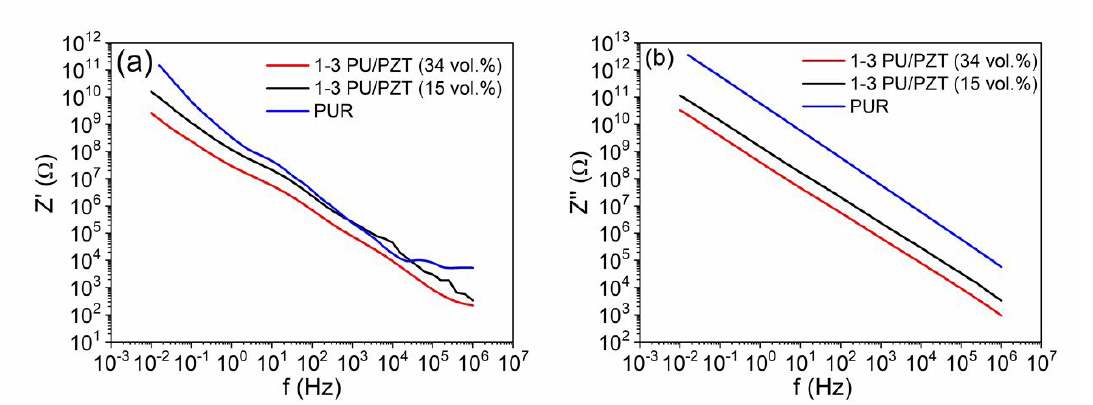
Figure 4. Impedance analysis of neat PUR and 1-3 PUR/PZT piezoelectric composite with different volumetric fraction of PZT rods. (a) real and (b) imaginary part of the impedance complex as a function of frequency at room temperature.